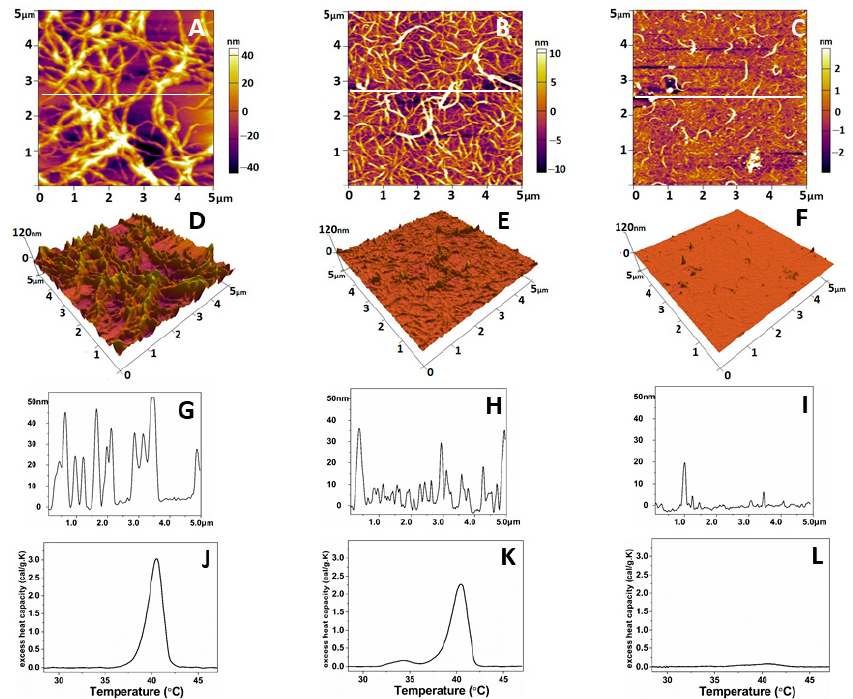
Figure 4. Representative 2D AFM images of native (A), oxidized (B), and denatured (C) collagen; the corresponding 3D topographical images (D, E, and F) of the images of (A–C) and cross-section plot shapes (G,H,I) corresponding to the white lines in (A–C). The images were taken in tapping mode in the air at room temperature. The denaturation DSC profiles of native, oxidized, and denatured collagens were presented in panels (J–L), respectively.